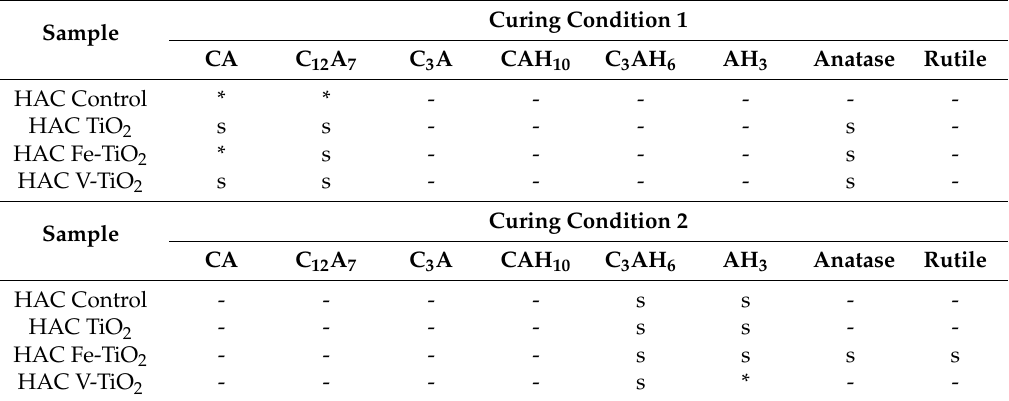
Table 4. Semi-quantitative XRD phase assemblage of aluminate phases and nano-additives in